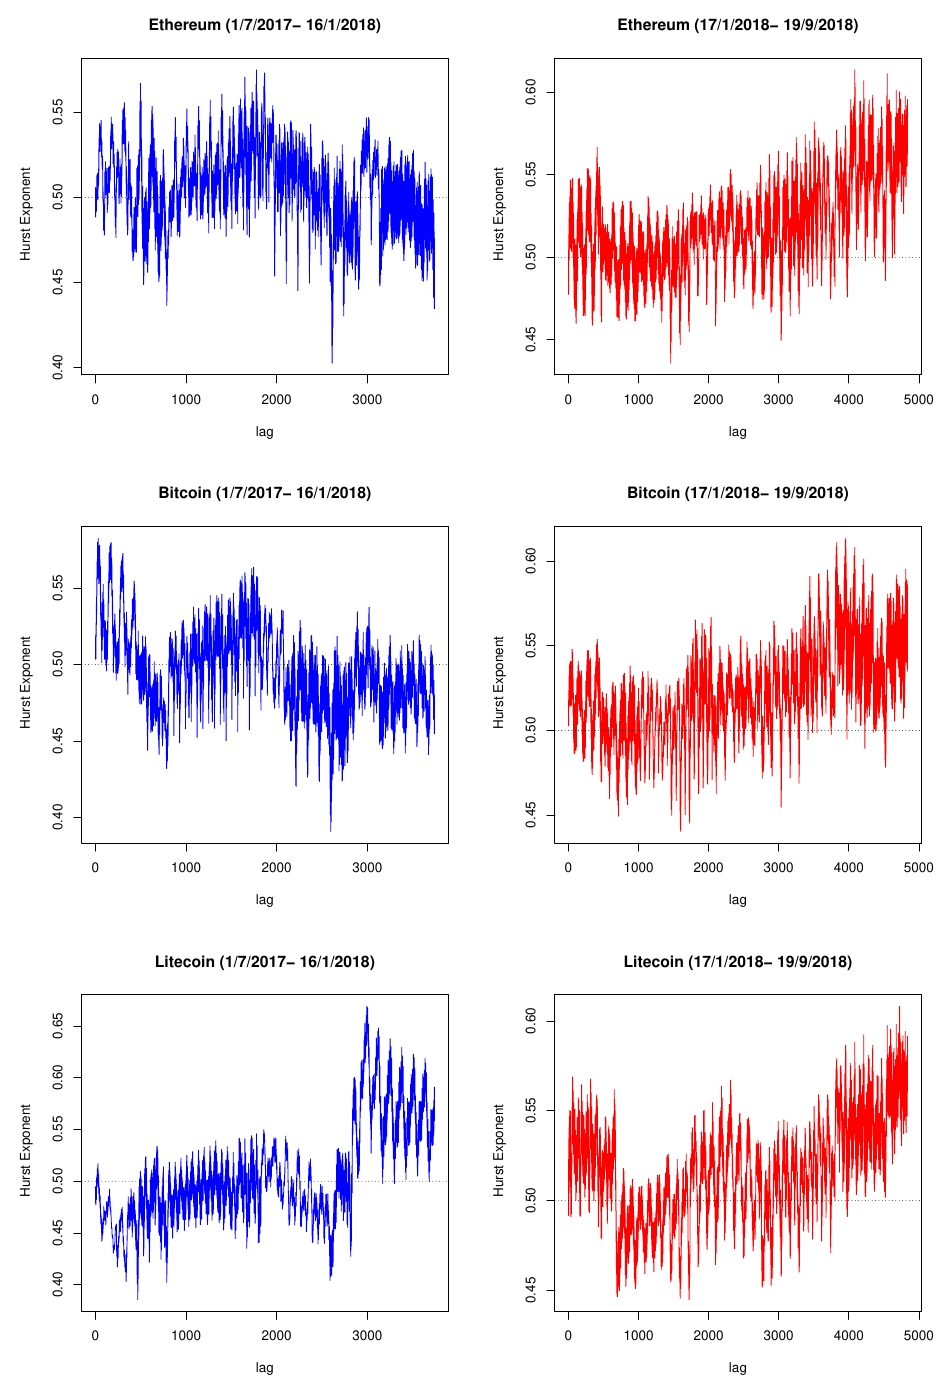
Figure 2. Plots of Hurst exponent of high-frequency 1 h log returns of ( top left , top right ) Ethereum, ( middle left , middle right ) Bitcoin, and ( bottom left , bottom right ) Litecoin using a sliding window of 720 lagged data points. Bull and bear markets indicated by blue and red lines,